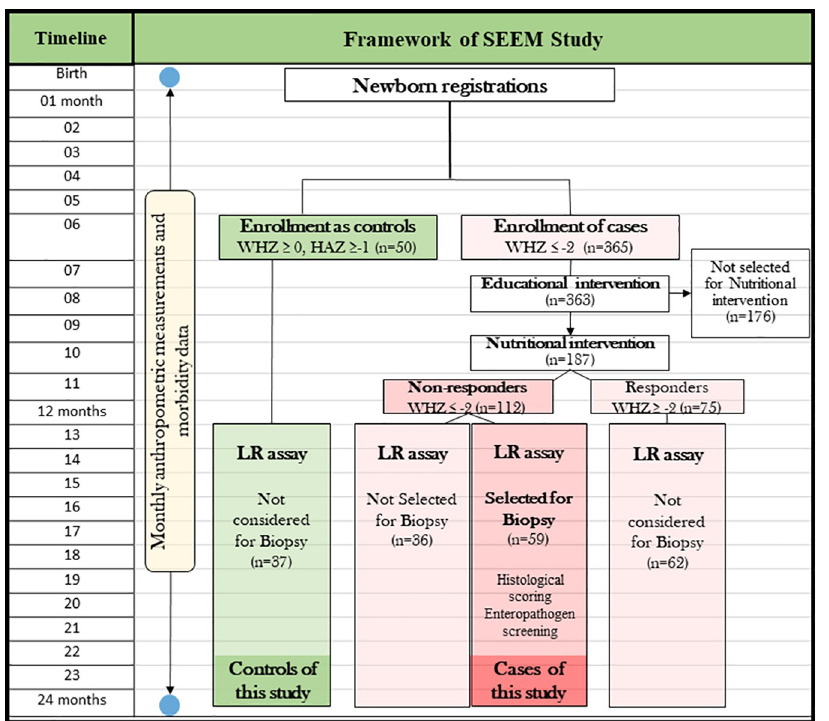
Fig 1. Graphical representation of SEEM study participants and selection of cases with wasting undernutrition refractory to RUST